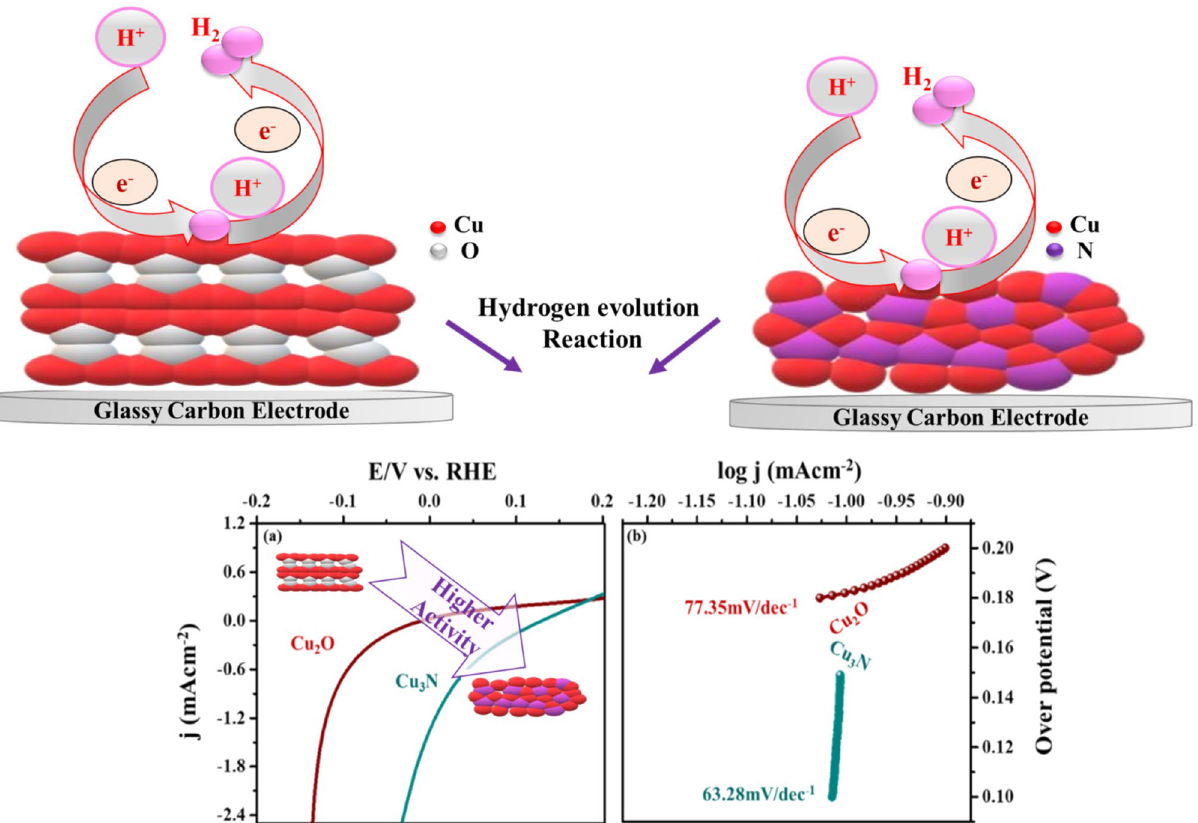
Figure 14. A schematic on the activity of HER using Cu 2 O and Cu 3 N